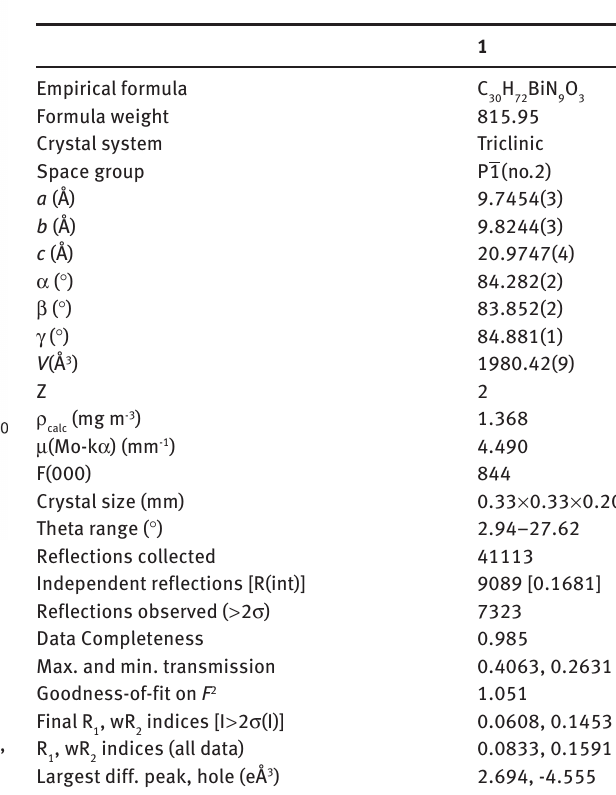
Table 1 Crystal data and structure refinement for 1